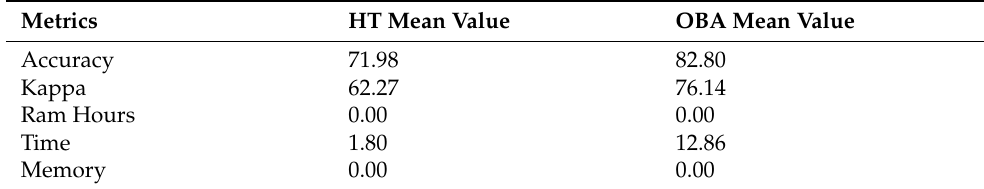
Table 3. Hoeffding tree (HT) and OzaBagAdwin (OBA) multiclass classification results.